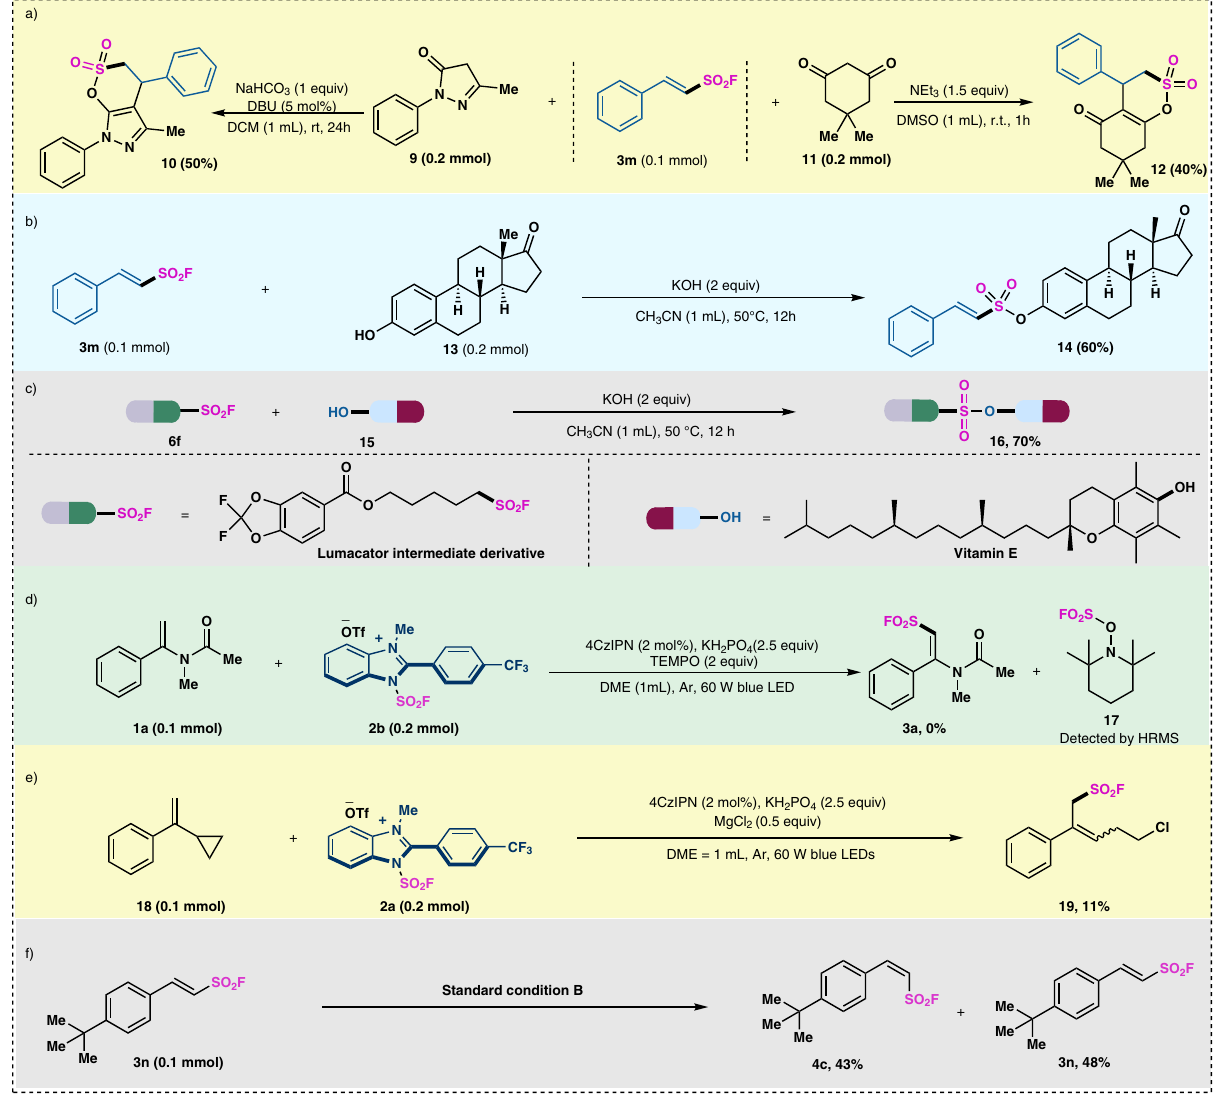
Fig. 5 Synthetic applications and mechanistic studies. a Cycloaddition of alkenylsulfonyl fl uoride. b , c SuFEx click reaction of alkenylsulfonyl fl uoride 3 m . d Radical inhibition experiment. e Free radical clock experiment. f Control experiment for the production of Z -alkenylsulfonyl fl uoride. Methods General procedure for the synthesis of sulfonyl fl uoride imidazolium salt reagent 2 . Sodium hydride (60% dispersion in mineral oil.) (36 mmol, 1.2 equiv.)